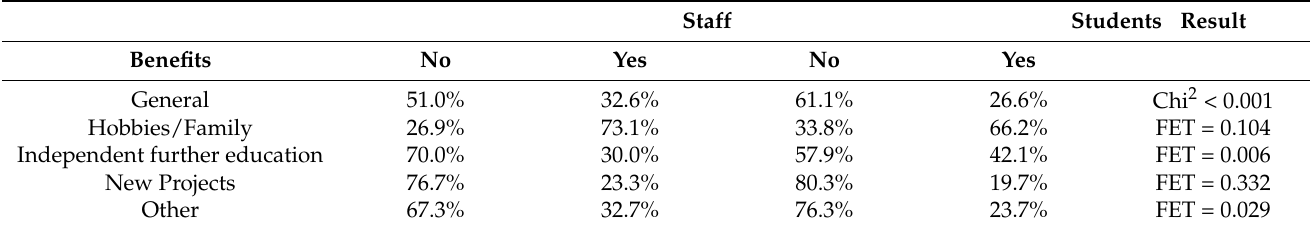
Table 4. Benefits of the